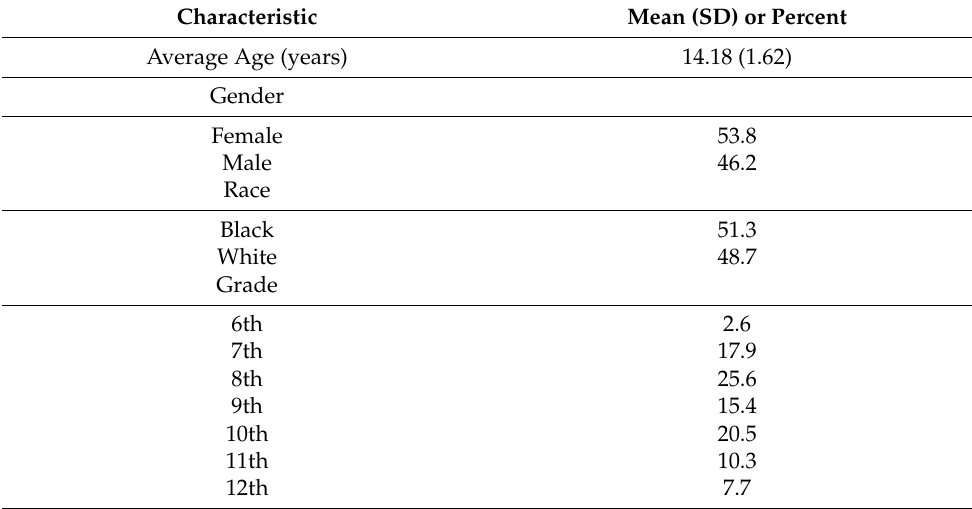
Table 3. Sociodemographic characteristics of the sample ( n =